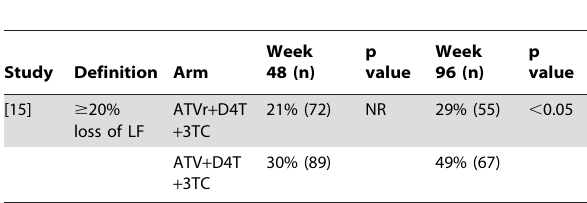
Participants Twelve randomised controlled trials enrolled antiretroviral- naı¨ve participants [3,9,10,12,13,15,17–19,22,24,33]. The cohort study [8], seven randomised controlled trials [4,11,14,16,21,23,32], and all the switching studies enrolled antiretroviral-experienced participants. The cohort study enrolled participants both with and without lipodystrophy. Two rando- mised controlled trials enrolled only participants with clinical or self-reported features of lipoatrophy [23,32]; and two enrolled Table 10. Proportion of patients with peripheral lipoatrophy on DEXA scan: PI versus PI.